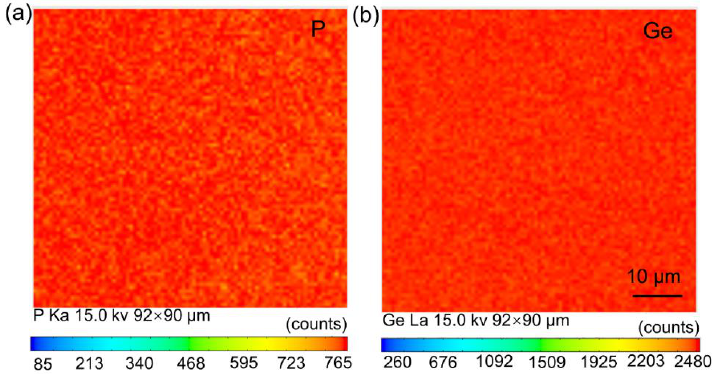
Figure 5. The elemental mapping images of Ge ( a ) and P ( b ) measured by electron probe microanalysis (EPMA). Figure 4. Raman spectrum of GeP crystal marked with A g and B g Raman modes.